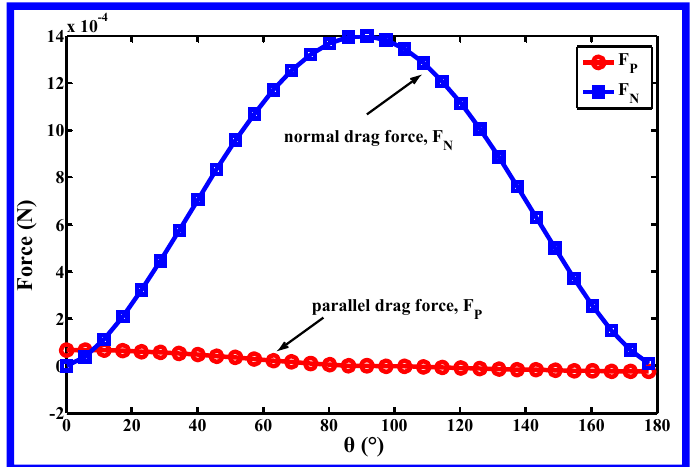
θ under the same Figure 2. Fp , F N with respect to θ under the same assumption. Figure 2. Fp , F N with respect to